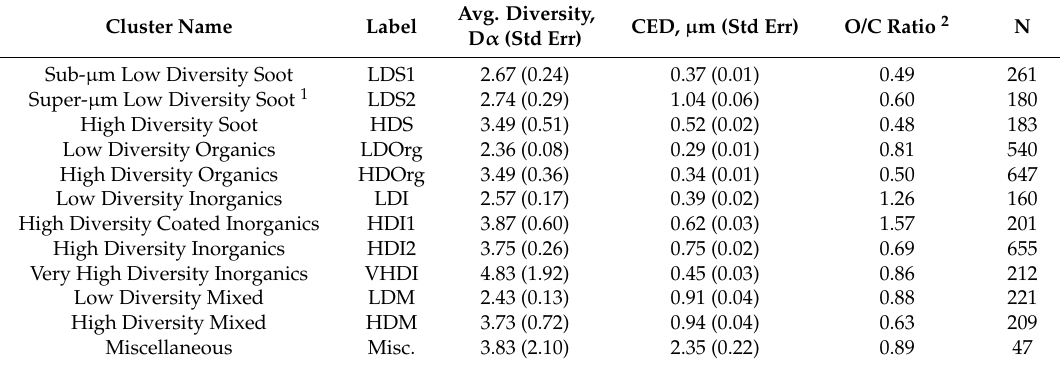
Table 3. Cluster identifying